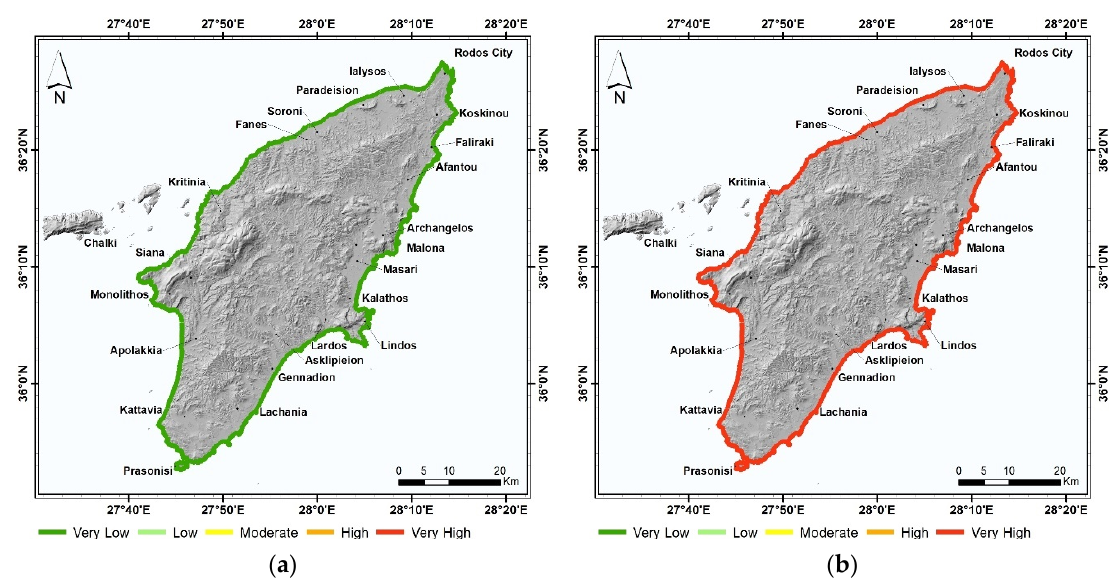
Figure 3. Evaluation of the relative vulnerability due to the mean absolute SLR rate in Rhodes Island: ( a ) The current situation and ( b ) condition projected to 2100.